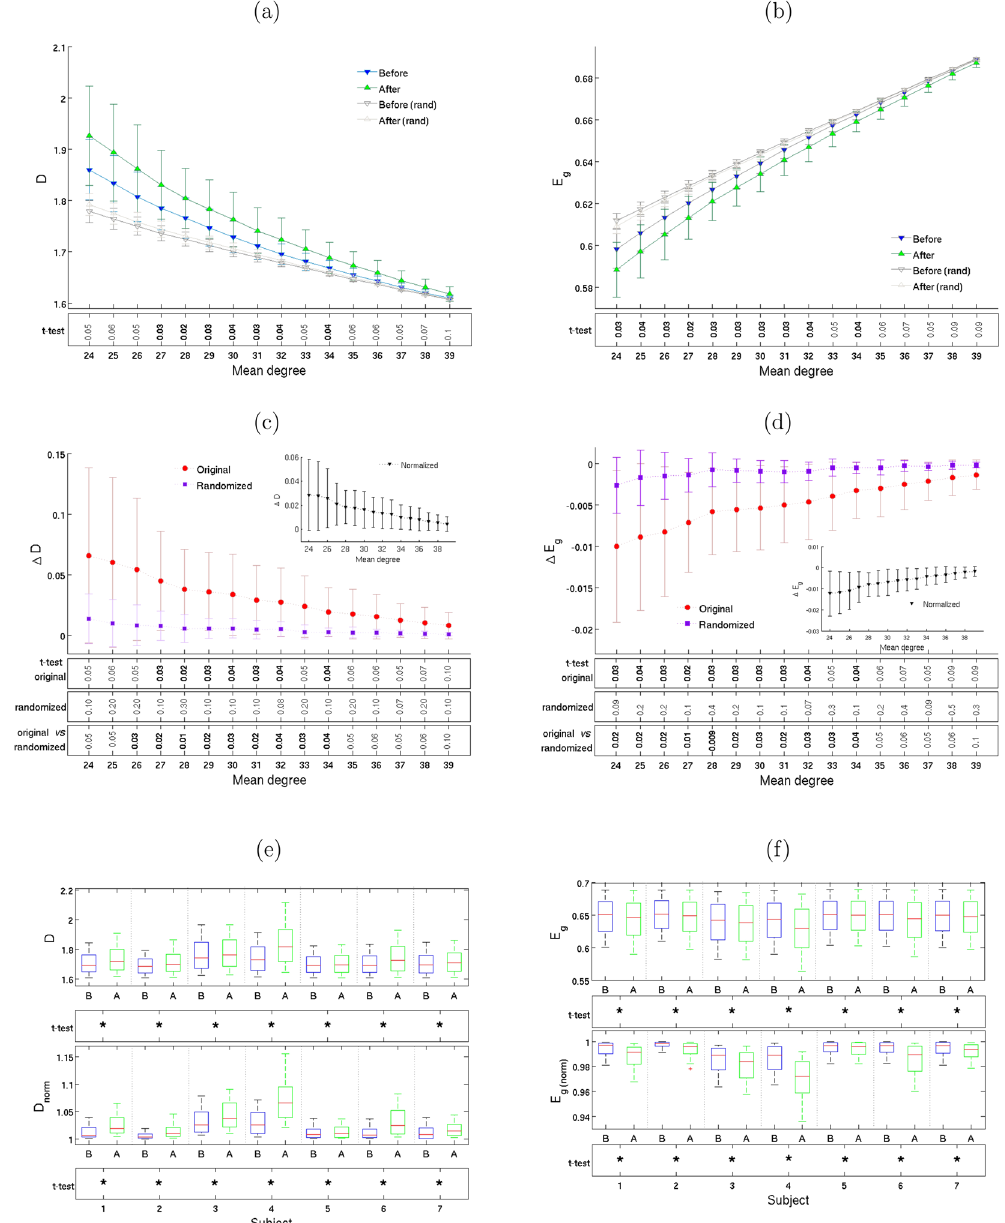
Figure 5. Global efficiency and integration decrease. Geodesic distance D (left column) and global efficiency E g (right column). Plots ( a ) and ( b ) show means ± 1 standard deviations, calculated from the complex networks of all 7 subjects, as well as from their corresponding iso-entropic randomized networks, for 16 different mean degrees. Plots ( c ) and ( d ) show the change in D and E g after Ayahuasca ingestion. The inset shows normalized values (see text). Boxplots ( e ) and ( f ) show the same information, subject-by-subject. As in previous figures, the rows below the plots show p -values for the t -test, with asterisks ( * ) indicating p <